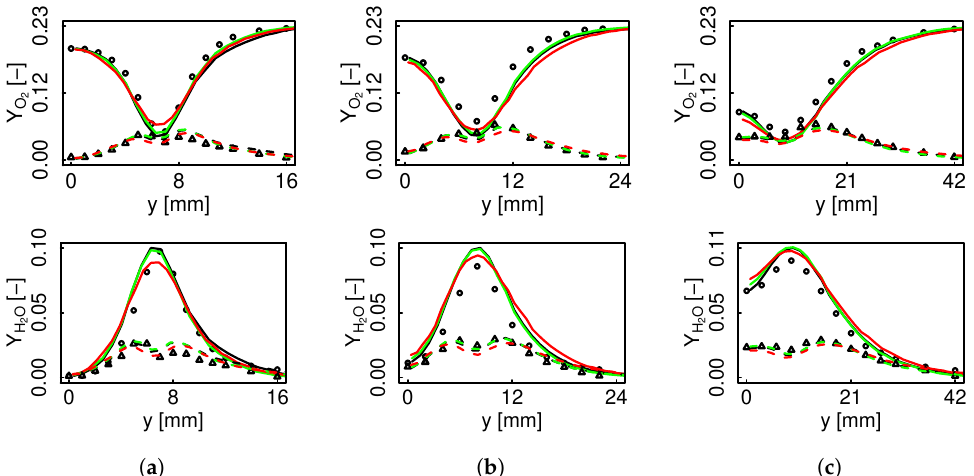
Figure 13. O 2 and H 2 O mean and RMS radial profiles for flame D. Black color represents non- premixed FTACLES, green color premixed FTACLES, red color FPV, solid line mean, dashed line RMS. Circles depict experimental mean, and triangles represent experimental RMS. ( a ) x / d = 7.5; ( b ) x / d = 15; ( c ) x / d =